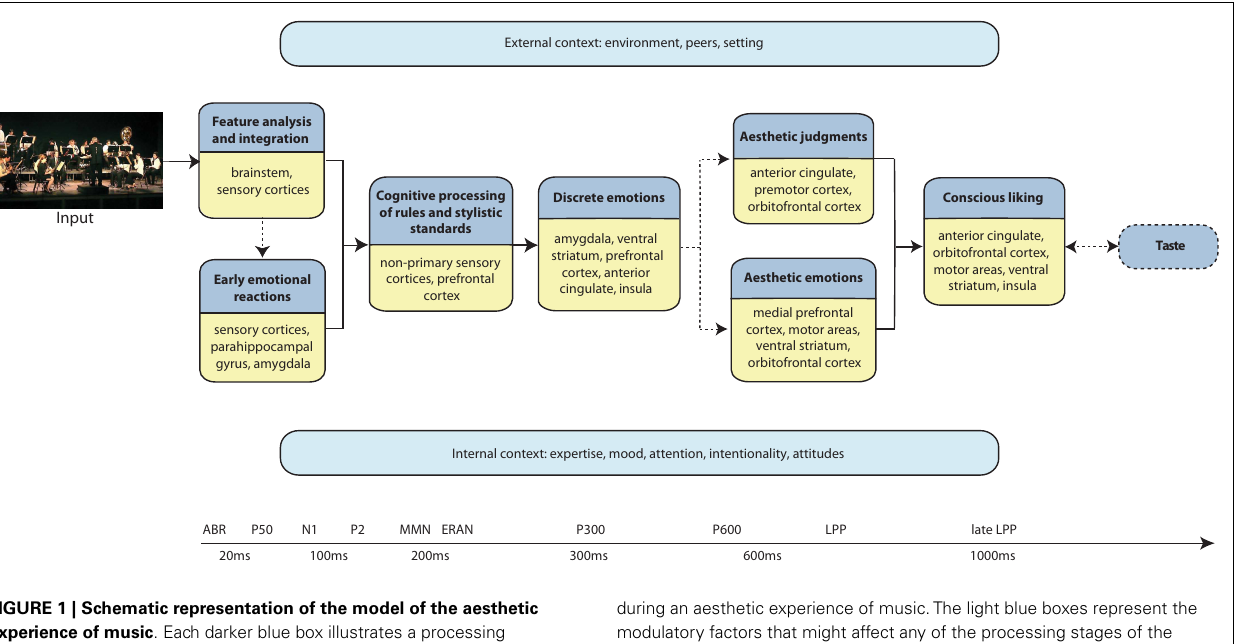
FIGURE 1 | Schematic representation of the model of the aesthetic experience of music . Each darker blue box illustrates a processing component, with the brain structures indicated in the accompanying yellow box.The chronological succession of processing flows from left to right.The arrows represent pathways of information flow between processing components.The dashed lines indicate processes that may not always occur